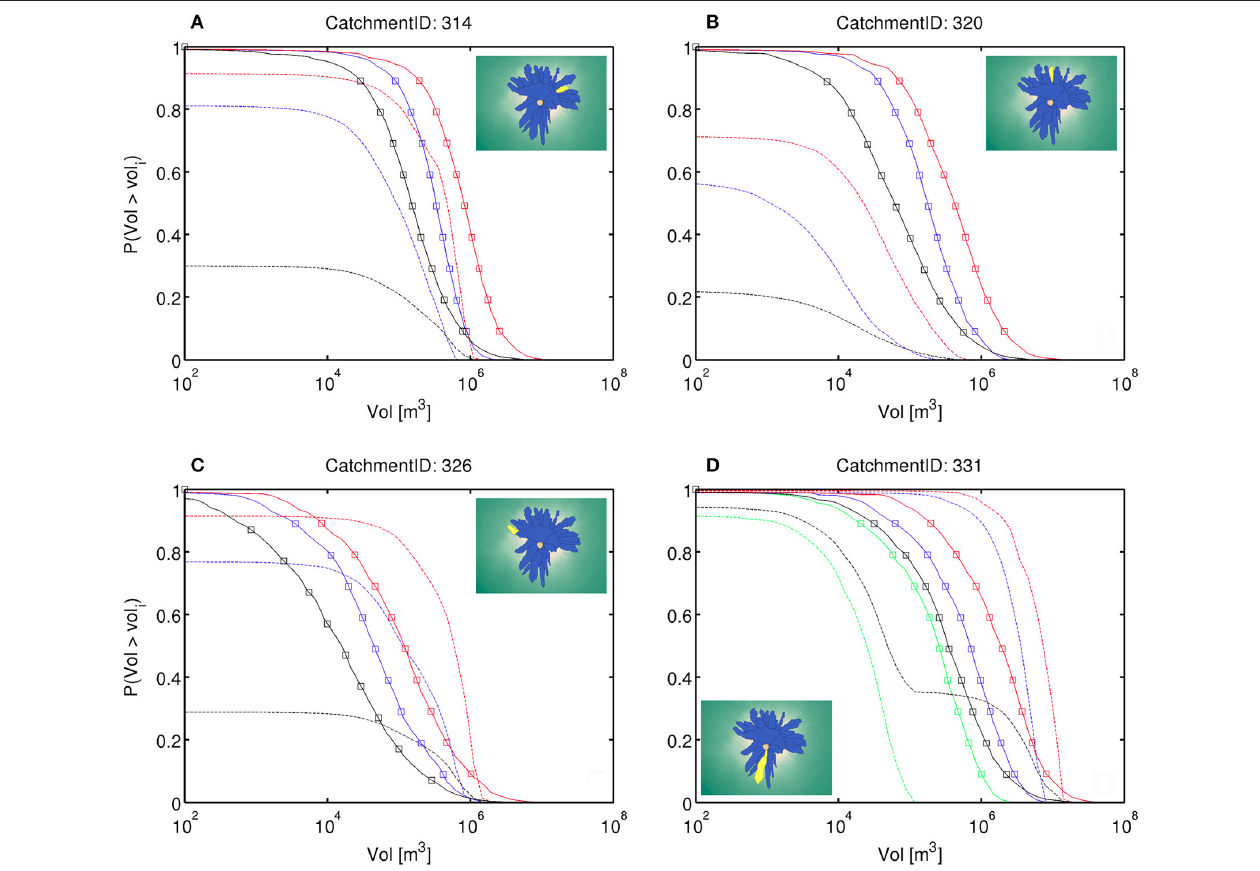
FIGURE 6 | Hazard curves (or Exceedance Probability curves) for the volume of pyroclastic material (Vol), produced by tephra fallout (solid lines with squares) or dense PDCs (dashed lines), at four selected catchments over the flanks of Somma-Vesuvius (Italy): #314 (A) , #320 (B) , #326 (C) , #331 (D) . The colors indicate the eruption size: small (green), medium (blue), large (red), and any size (black, see text for more details). The inset maps show the location of the corresponding catchment (in yellow) and the other catchments on the Somma-Vesuvius flanks (in blue). Napoli downtown is located outside the maps, around 10 km toward the